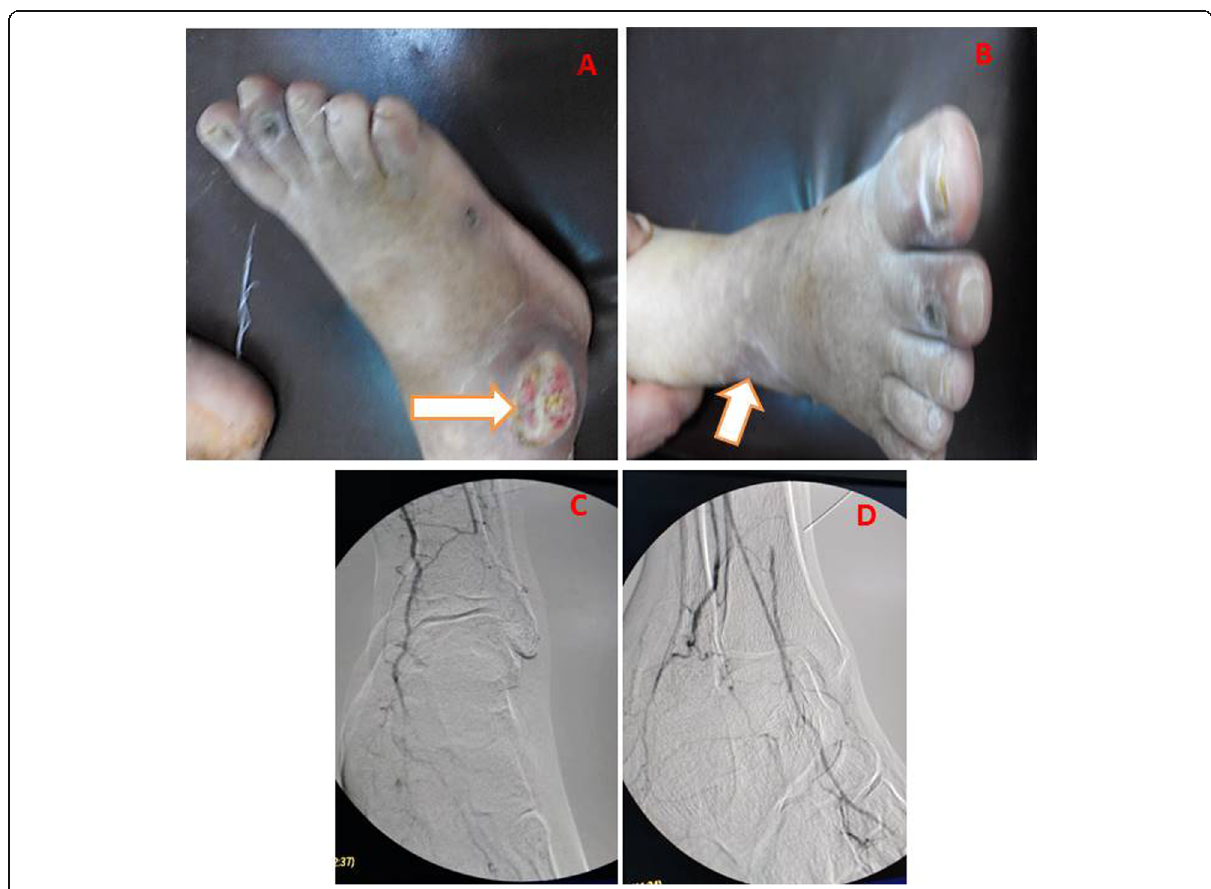
Fig. 6 A 60-year-old male patient presented by unhealed Rt. foot ulcer: a Pre-procedure foot with large lateral aspect ulcer overlying the lateral malleolus. b Post-procedure follow-up with evident healing of the ulcer in few weeks. c Pre-procedure angiogram antero-posterior view for the distal leg and foot revealed attenuated terminal part of the peroneal artery. d Post-procedure angiogram showed recanalized peroneal artery as well as the ATA